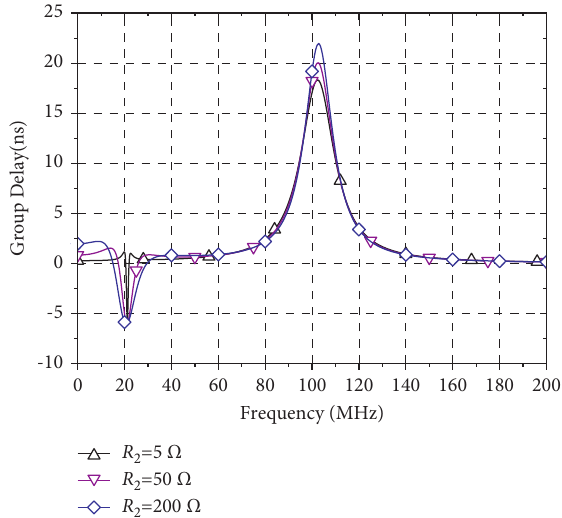
Figure 14: Negative delay of band pass in the band-pass filter with different R Table 6: Element values of the band-pass negative group delay circuit with different R